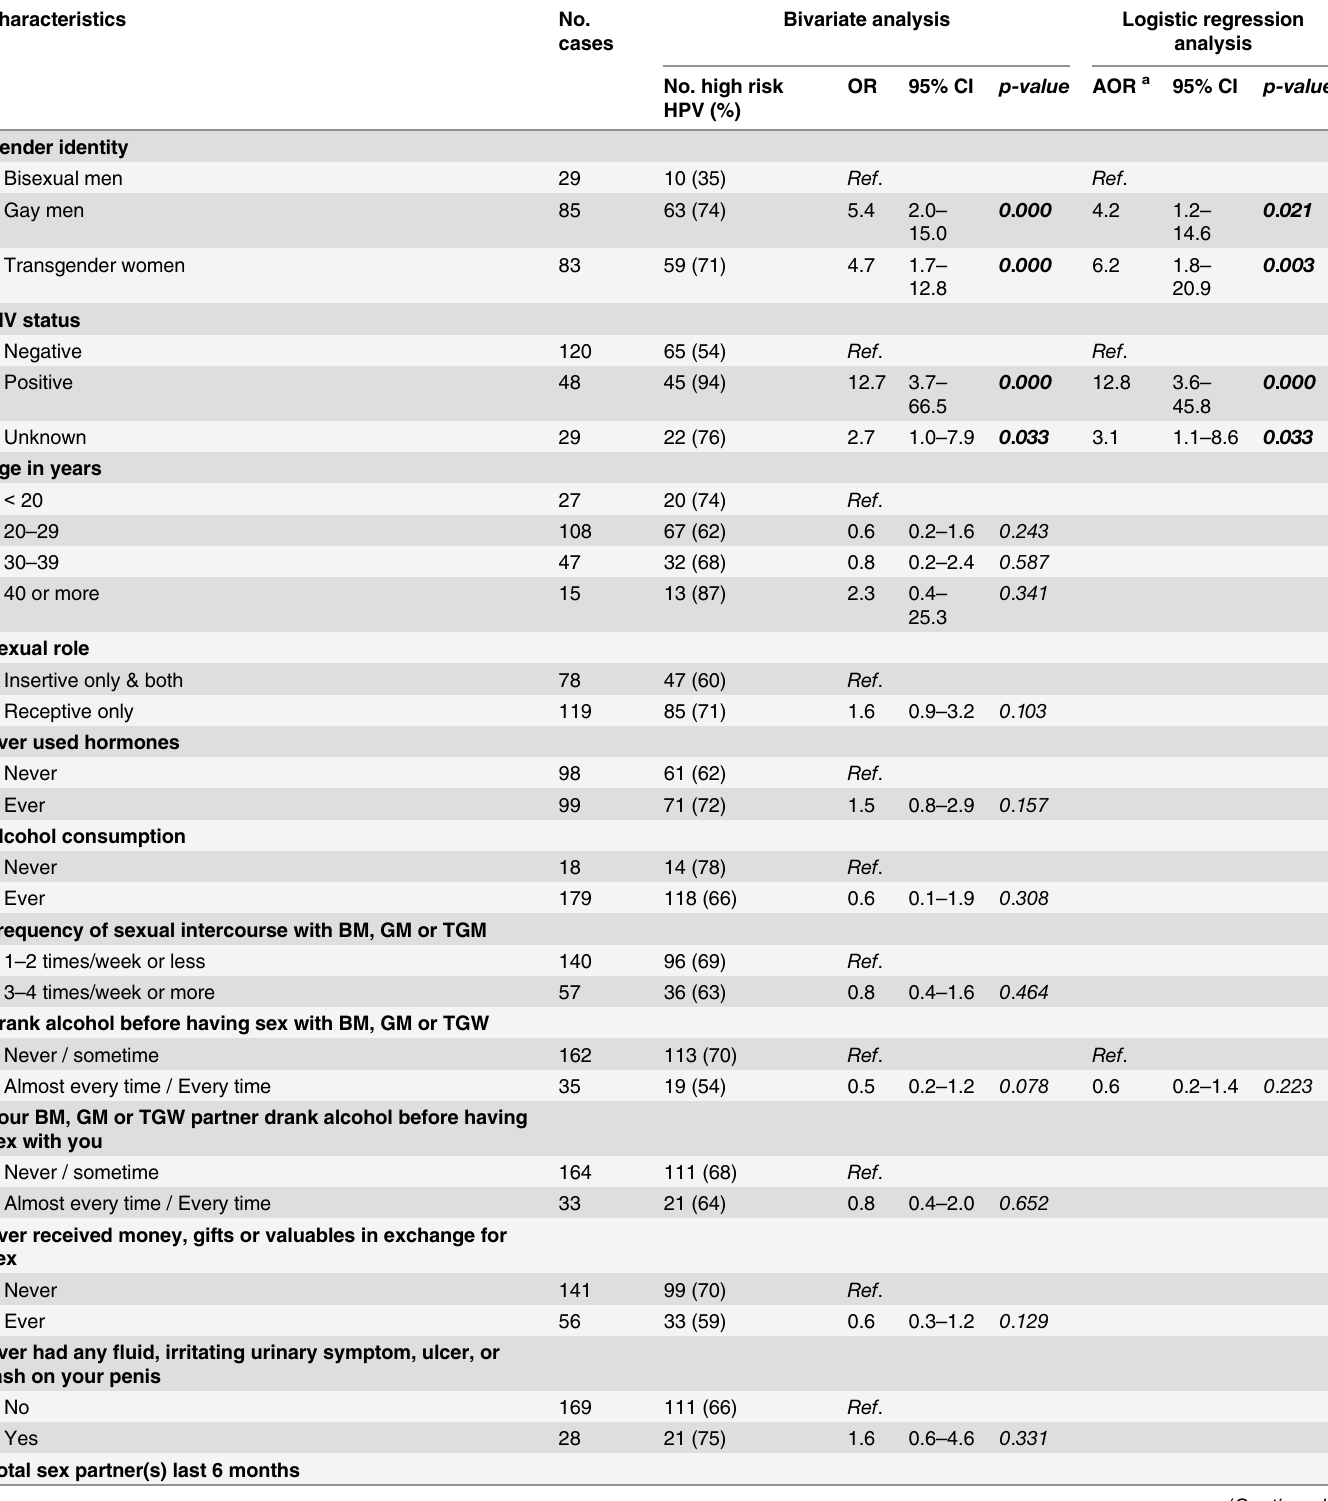
Table 7. Crude and adjusted odds ratios by bivariate and logistic regression, for high-risk-type HPV positivity, by demographic, behavioral, and sexual risk factors of MSM in Chiang Mai, Thailand.